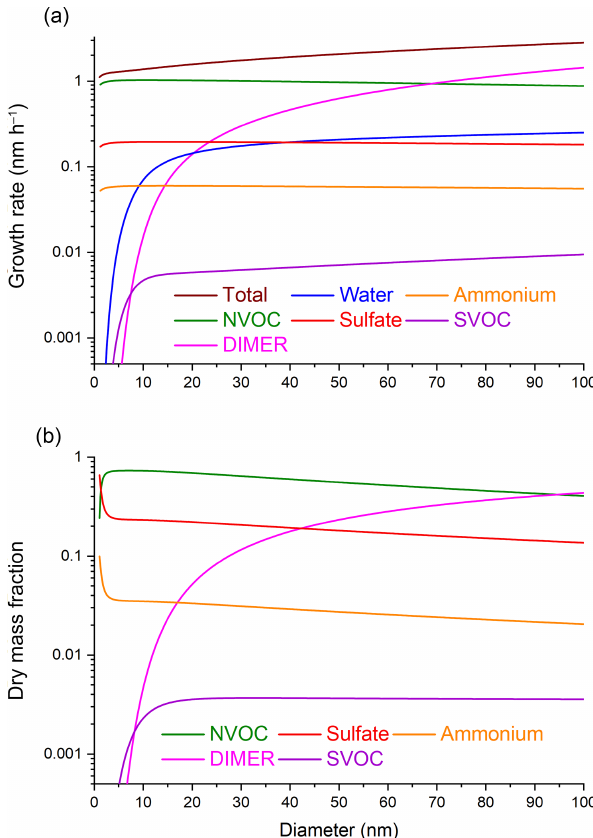
Figure 3. Particle diameter dependence of (a) growth rates and (b) dry mass fractions of chemical species under the conditions where both partitioning and particle-phase chemistry (SVOC– SVOC dimer formation) are included.